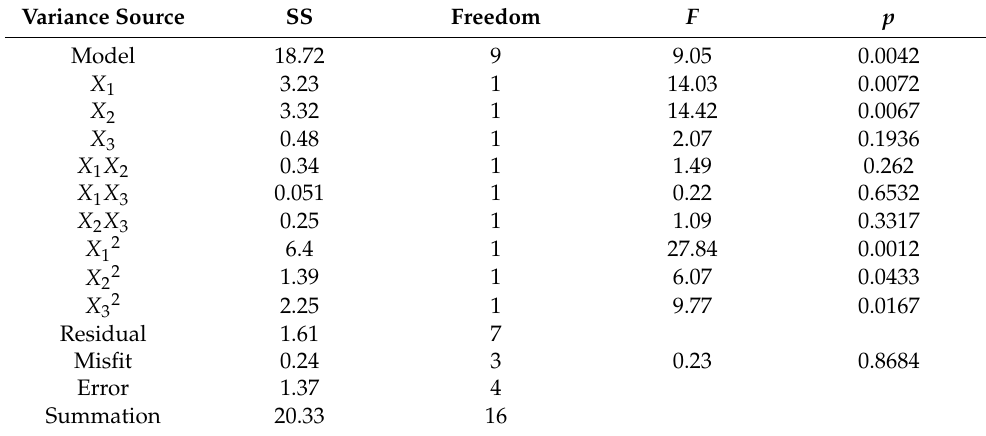
Table 6. ANOVA of reseeding